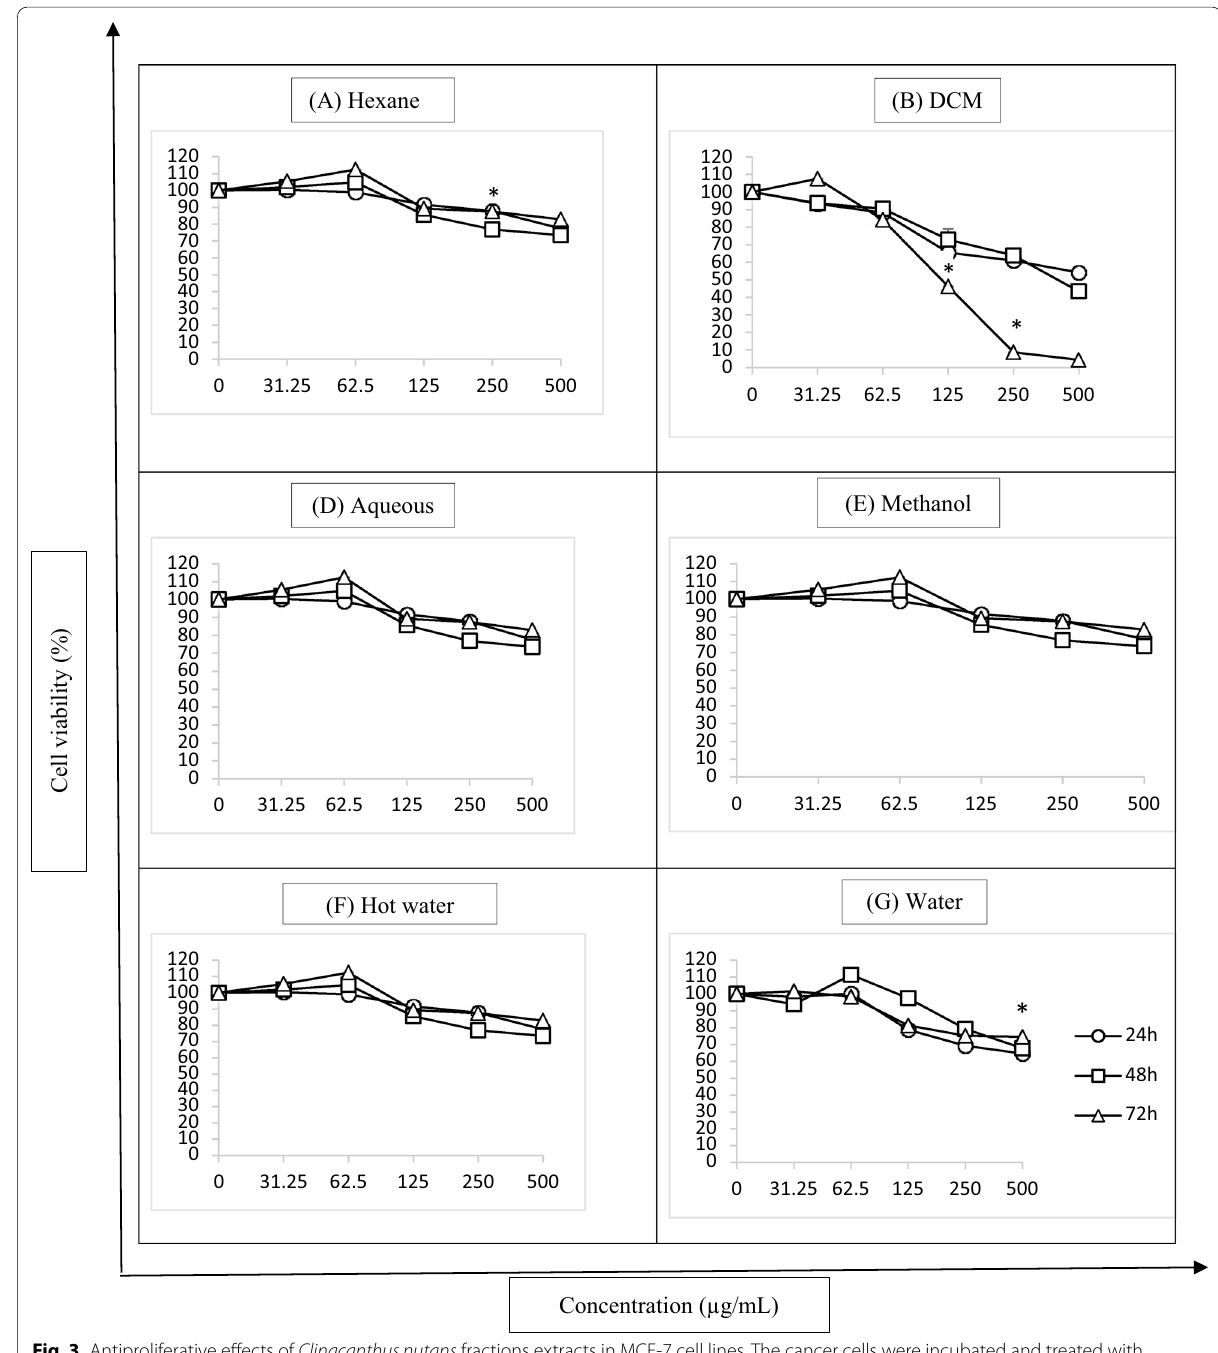
Fig. 3 Antiproliferative effects of Clinacanthus nutans fractions extracts in MCF-7 cell lines. The cancer cells were incubated and treated with increasing concentrations of different solvent extracts (hexane, DCM, aqueous, methanol, hot water and water). Various concentrations were used from 31.25 to 500 µg/mL for 24, 48 and 72 h. The antiproliferative effect was measured by SRB assay. Data shown are the mean values independent experiments, and statistical analysis was determined using Student’s T test with * P < 0.05 significantly different to control